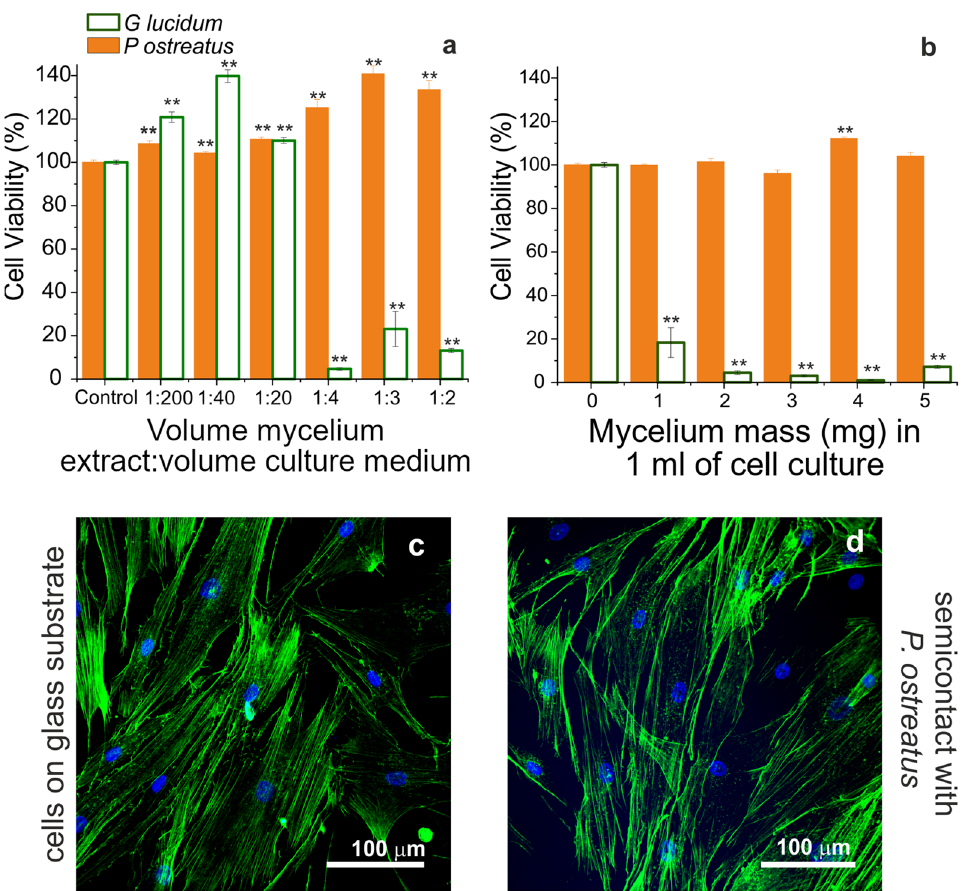
Figure 4. Biocompatibility towards HDFA cells. ( a, b ). Primary human fibroblast (HDFa cells) viability in the presence of mycelia extract ( a ) or semi-contact ( b ) as measured by MTS assay after 24 h. The reported values indicate the dilutions prepared starting from a stock solution of 20 mg of mycelium in 1 mL of Medium 106 containing growth factors. Data are expressed as average ± standard error and a p < 0.01 (**) was considered as significant. ( c, d ). Confocal images of control cells plated onto glass substrates and treated with Medium 106 containing growth factors ( c ), or in semi-contact with a 5 mg-piece of P. ostreatus ( d